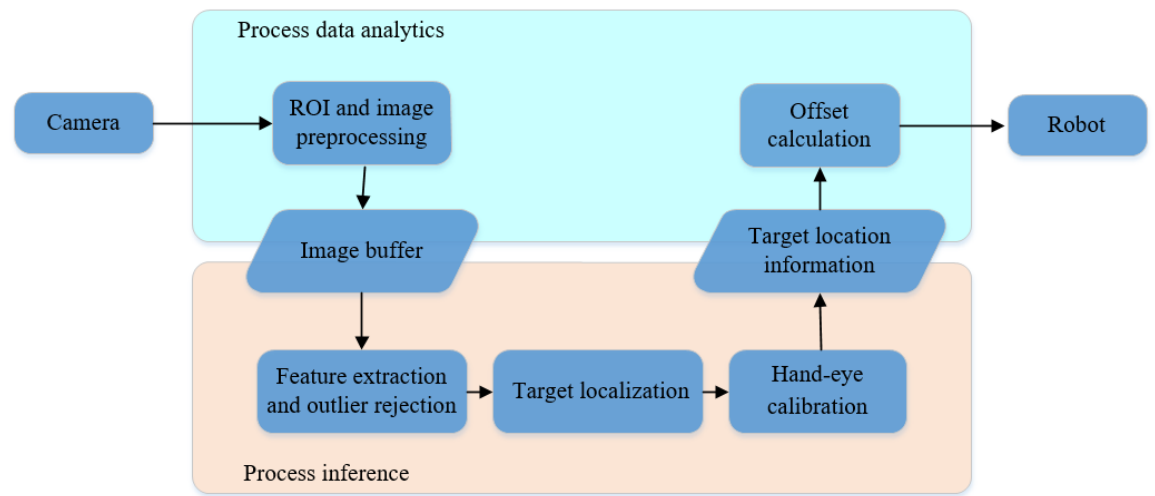
Figure 4. Data flow of the visual localization system.